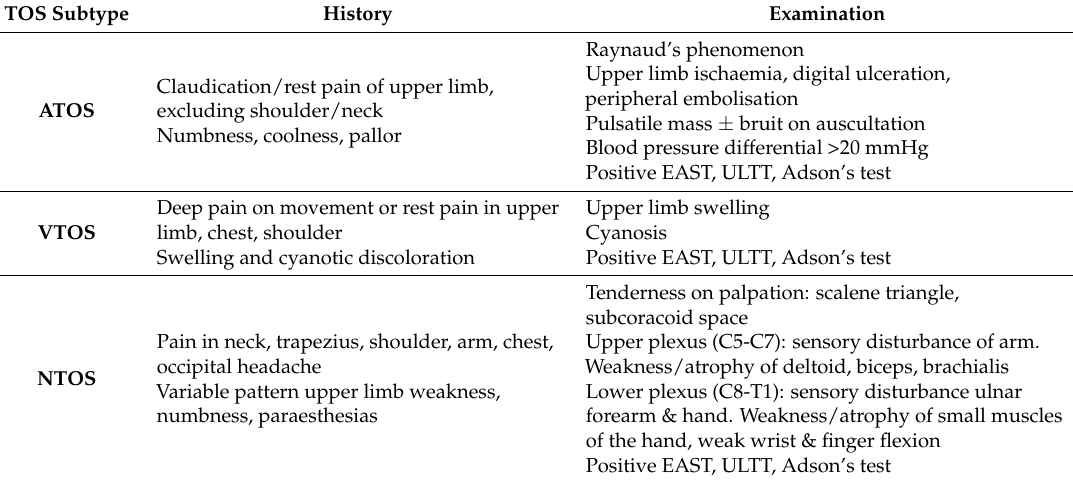
Table 1. History and examination features in ATOS, VTOS, and